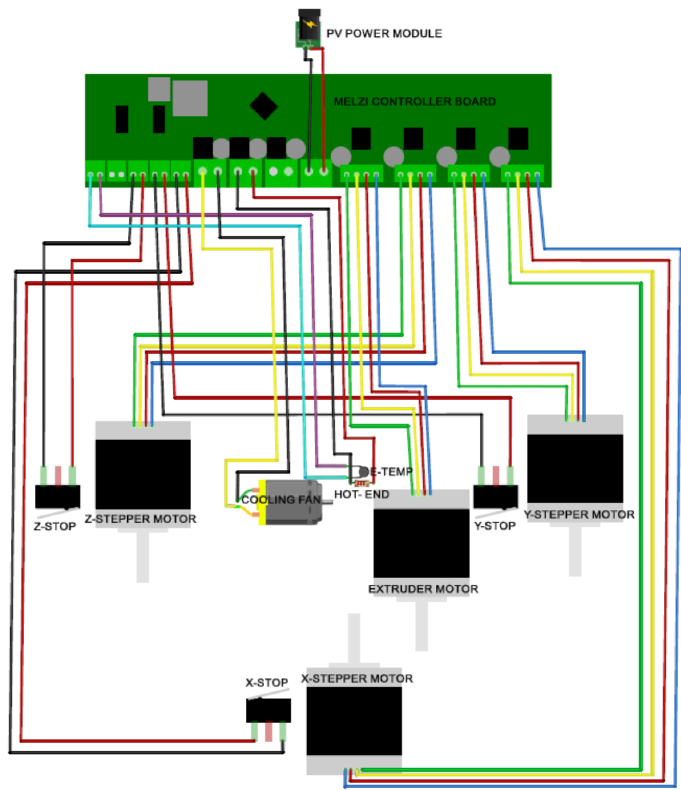
Figure 2. Fritzing schematic electronic diagram of MOST Delta RepRap.